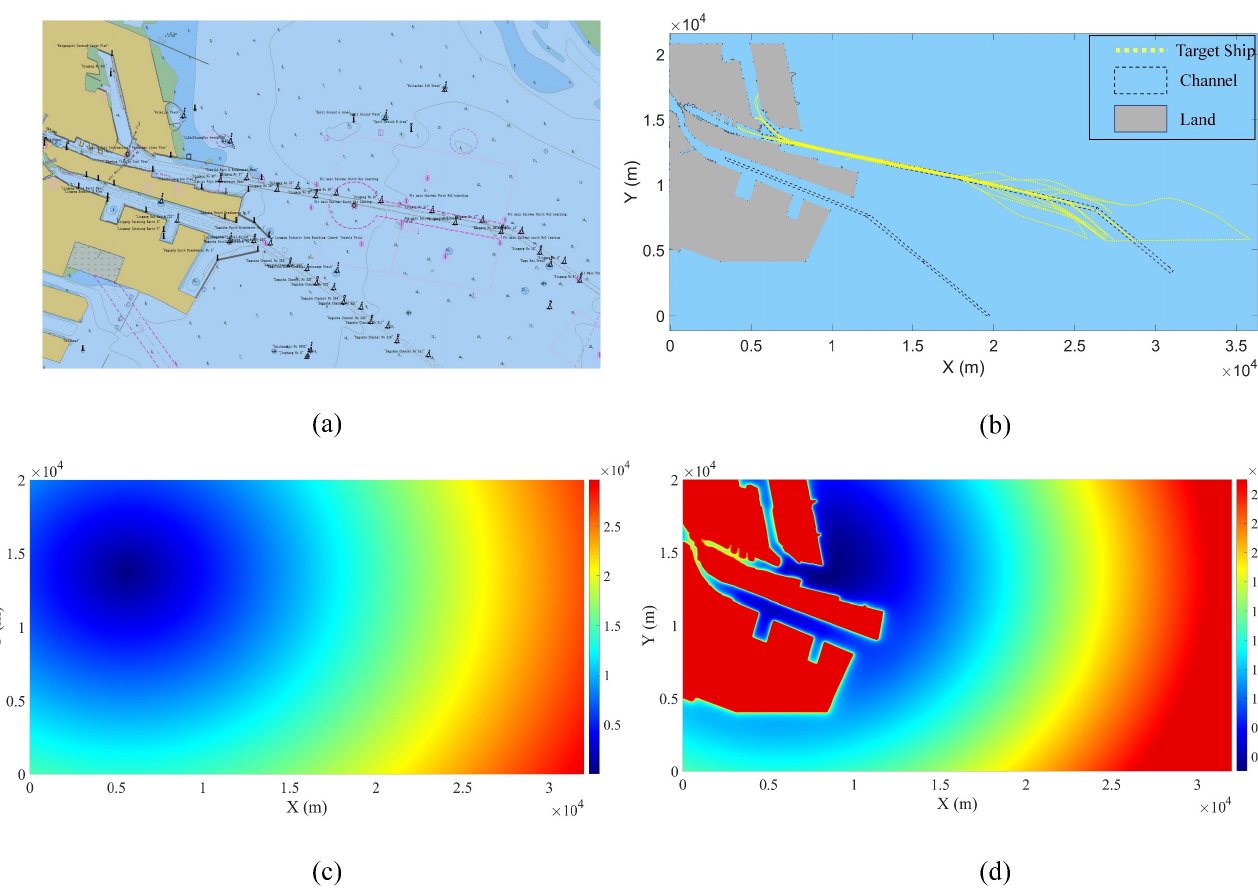
Figure 14. ( a ) Electronic navigational chart of Tianjin Port; ( b ) extraction of target ship trajectory, land and channel areas; ( c ) gravitational potential field; and ( d ) superposition potential field.